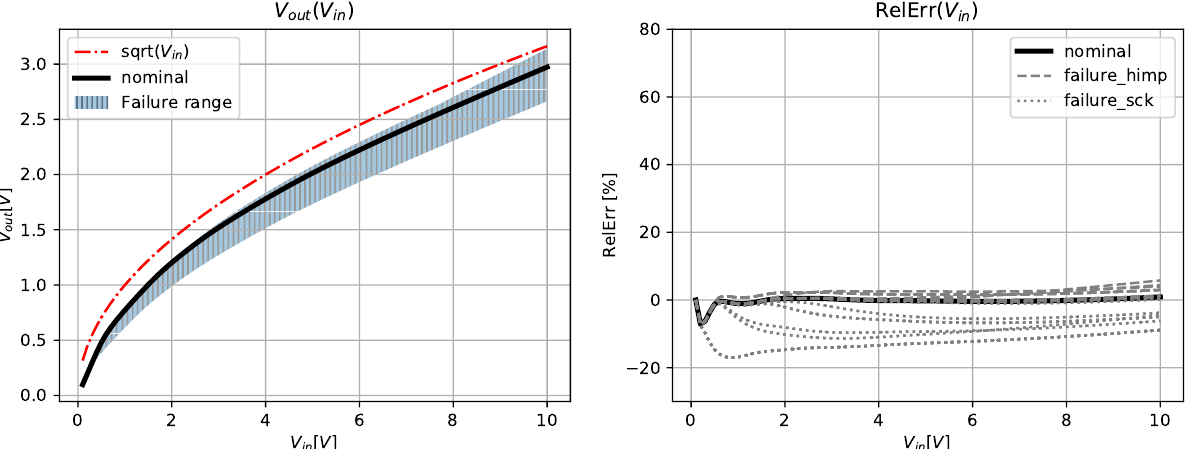
Figure 8. The voltage response of the resulting failure-resilient square root circuit. ( Left ):The complete output range, where the red (dash-dot) curve represents the ideal square root function, the black (solid) curve represents the failure-free circuit, and the gray area represents the range of responses with all possible single diode failures. ( Right ) Relative deviations from the ideal square root function −√ V in ) . A nominal design offset is subtracted from V out for RelErr ( V √ ( RelErr ( V in ) = V out V in ) max ( V out , representation. Stuck-open failures are drawn in dashed lines while stuck-short failures are drawn in dotted